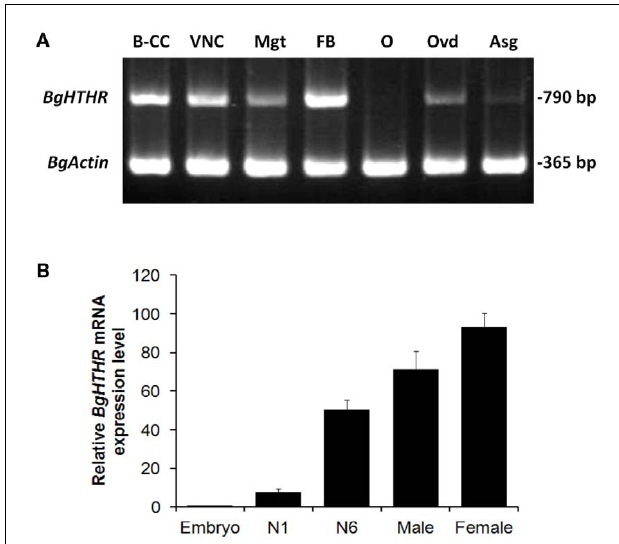
FIGURE 2 | (A) Semiquantitative RT-PCR analysis ( Blage-HTHR , 790bp) in various tissues: brain–CC–CA complex (B–CC), ventral nerve cord (VNC), midgut (Mgt), fat body (FB), ovary (O), oviduct (Ovd), and accessory gland (Asg) of 7-day-old adult females. BgActin expression (365bp) was used as a reference. (B) Quantitative real-time RT-PCR analysis of Blage-HTHR expression in the whole body of cockroaches at various developmental stages. N1 and N6 represent first and last (sixth) nymphal instars, respectively. Male and female are 7-day-old adults.The Blage-HTHR mRNA was normalized against BgActin expression. Data represent the mean ± SEM ( n = 3) of relative transcription levels normalized in comparison with embryo.